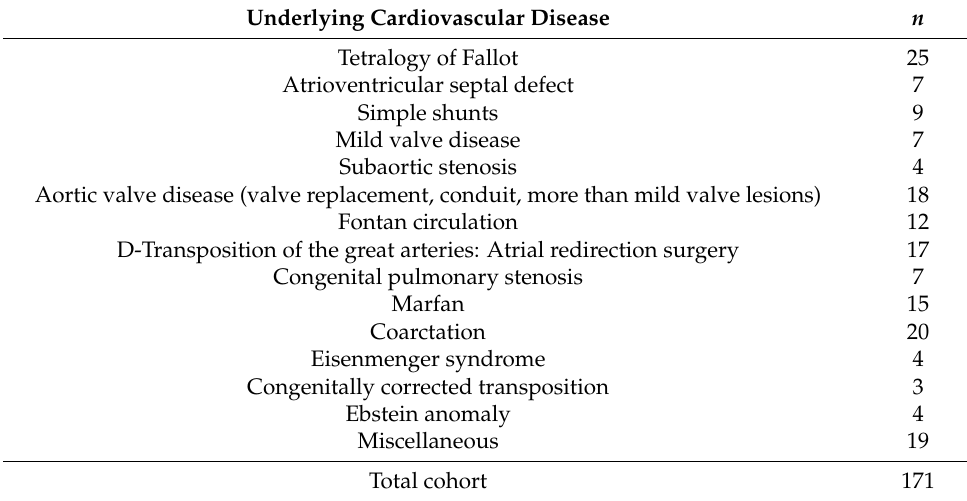
Table 1. Underlying congenital heart disease.